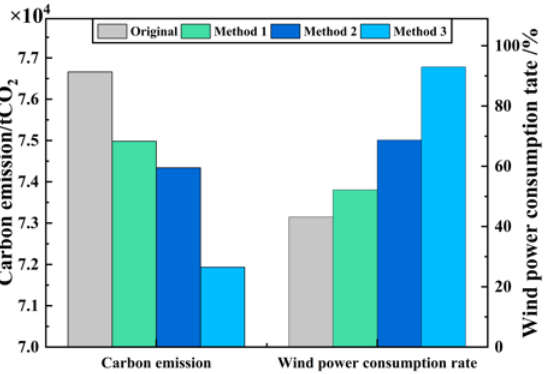
Figure 19. The system carbon emissions and wind power consumption rates with the different